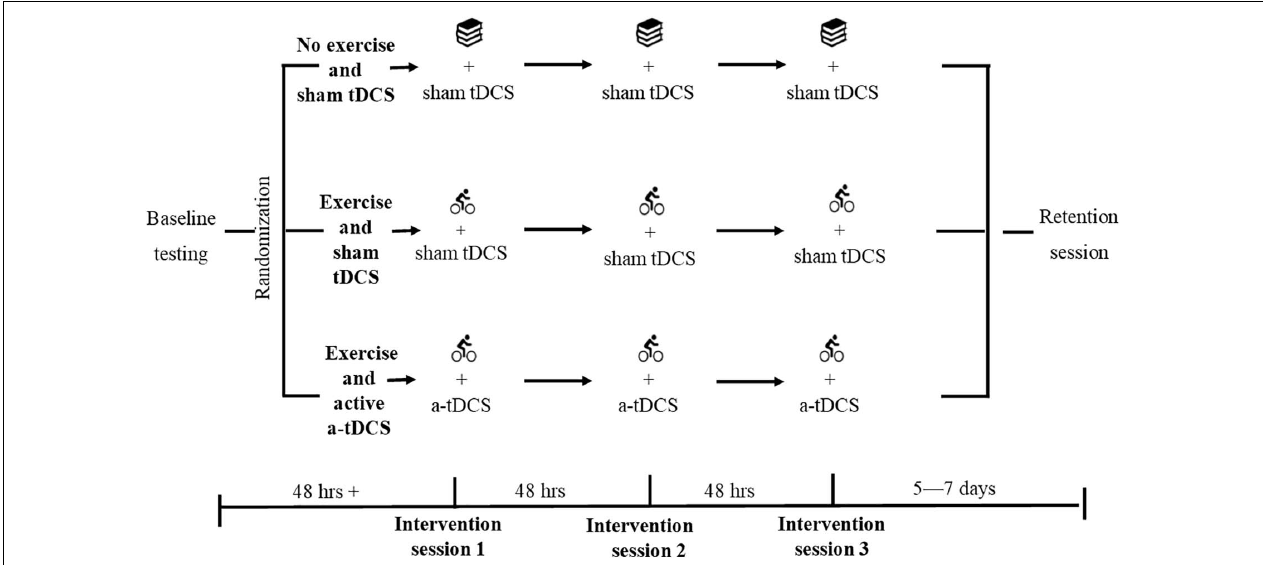
FIGURE 2 | Study design. Participants were randomized following standardized baseline testing. Each group then completed their assigned protocol at each of the three intervention sessions. The exercise and active a-tDCS group performed 20 min of cycling, followed by the learning task with active a-tDCS. The exercise and sham tDCS group performed 20 min of cycling, followed by the learning task with sham tDCS. The non-exercise and sham tDCS group performed 20 min of quiet reading, followed by the learning task with sham tDCS. The learning task and relevant tDCS protocol were applied within 10 min of the completion of exercise. All participants then completed a standardized retention session 5–7 days